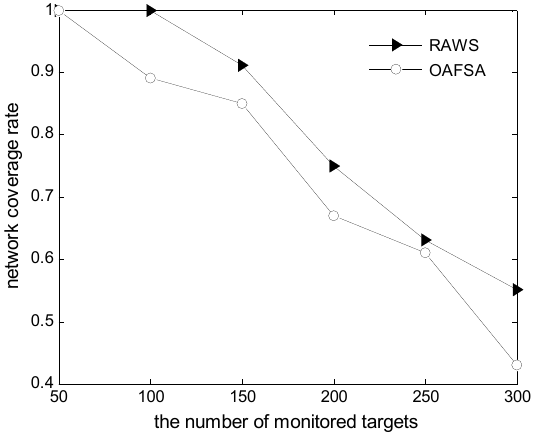
Figure 11. Comparison of average residual energy of nodes at varying numbers of monitored targets.